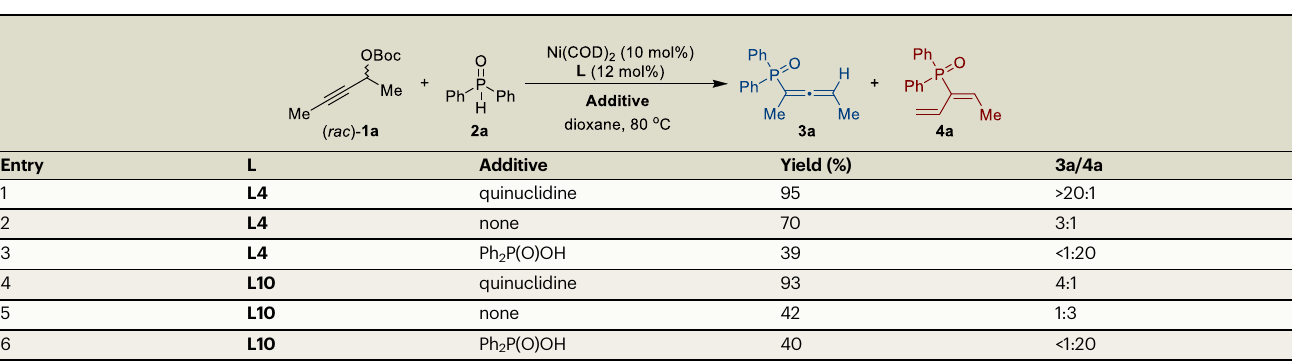
Table 3 | Additive effect on the outcome of the reaction